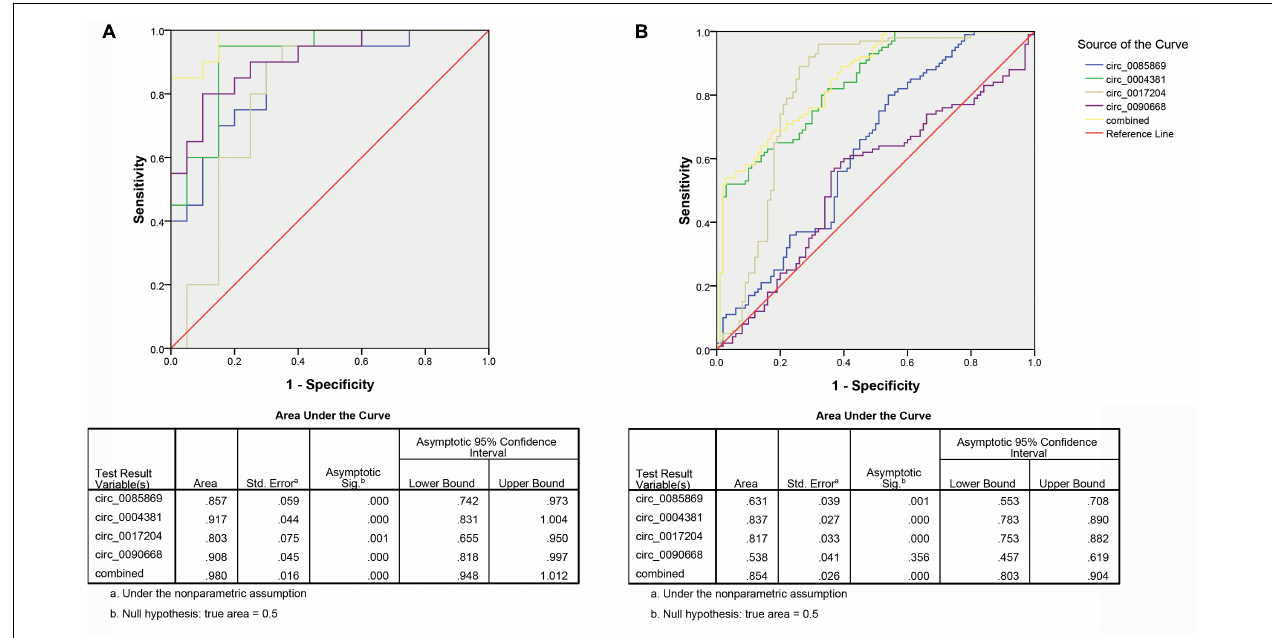
FIGURE 5 | ROC analysis of circRNA panel predicting early PD (stage 1) by using risk score analysis. (A) Training set. (B) Validation set.